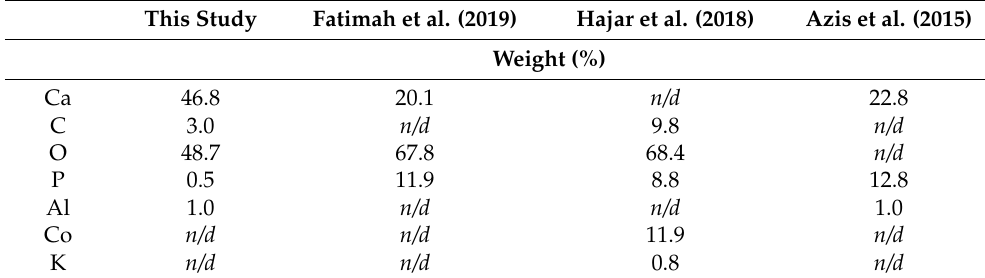
Table 2. Elemental components in the cockle shell powder.